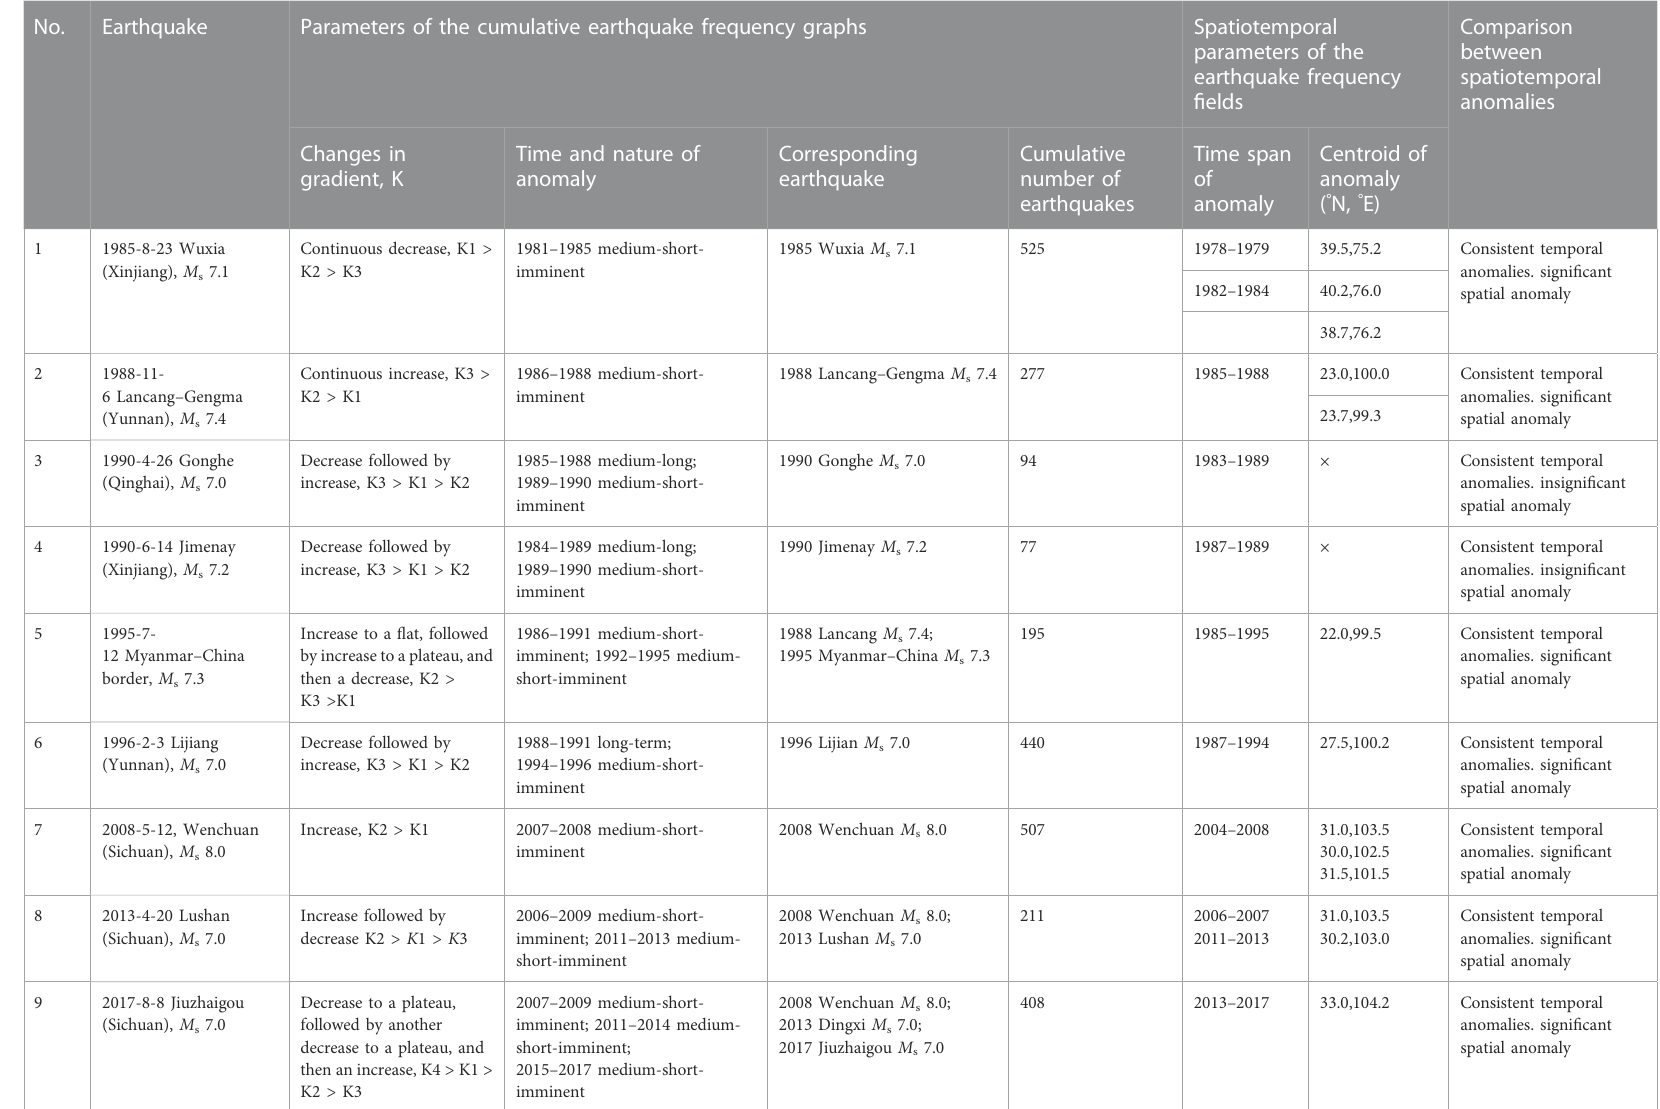
Note: × indicates that no anomalous zones were